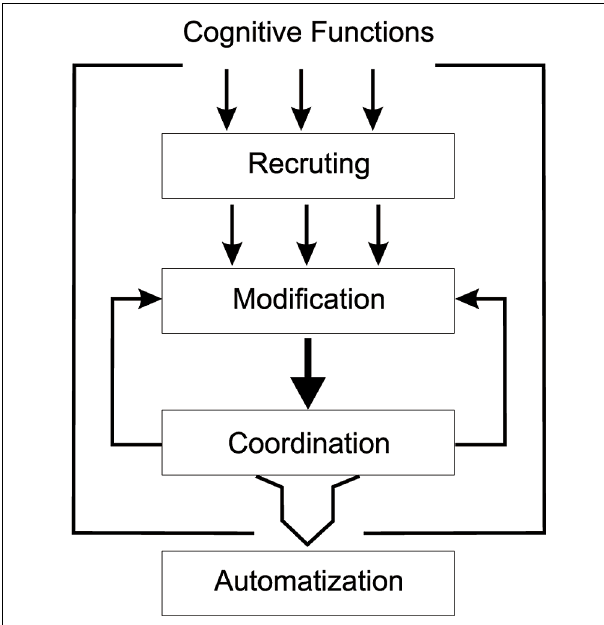
FIGURE 5 | Functional Coordination Framework for describing the processes involved in learning to read. Learning to read is described as a form of procedural learning in which, as a consequence of instruction, pre-existing functions and skills, principally from the visual and auditory domain, are recruited, modified and coordinated, leading to cross-modal codes of letters and procedures. After training these get automatized, after which experienced readers are biased against processing strategies for letter perception that do not form part of the procedure.The coordination stage is the most critical one, it stabilizes the modifications. A failure of coordination will result in automatization of an abnormal procedure, leading to reading and writing problems (Lachmann, 2002, 2008).The whole process, including the structural and functional changes related to it,